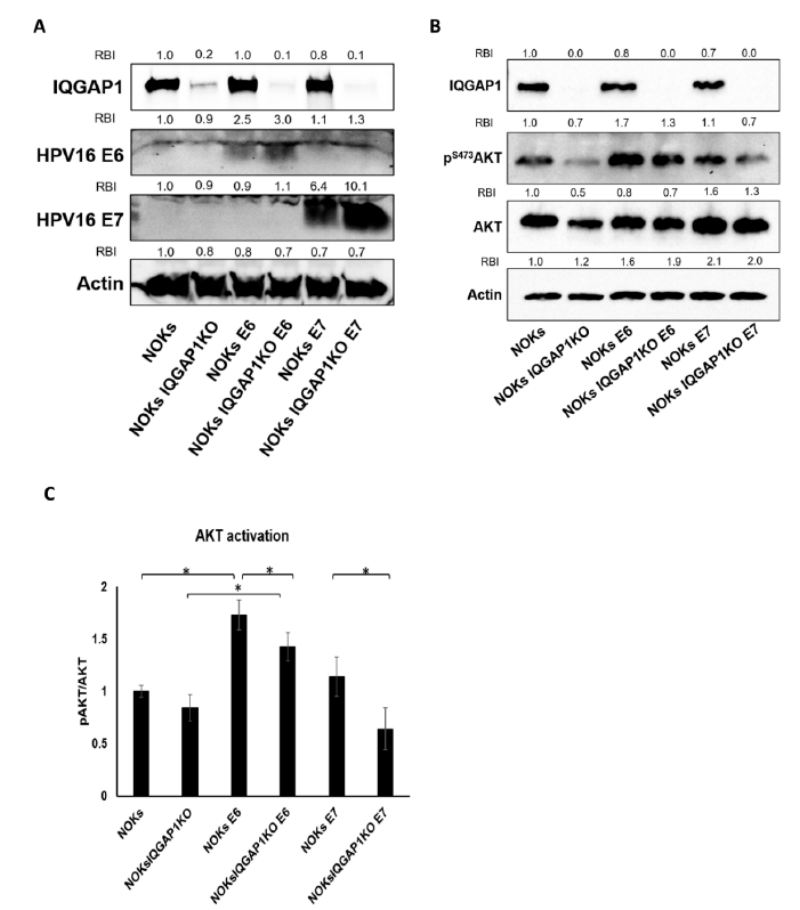
Figure 1. IQGAP1 is necessary for efficient HPV oncoprotein-induced PI3K signaling. ( A ) Im- munoblot to confirm the expression of IQGAP1, HPV16 E6, and HPV16 E7 in the constructed IQGAP1 KO NOKs-HPV cell lines. Relative band intensity (RBI) was calculated by normalizing to the band intensity of NOKs lane. ( B ) Immunoblot shows that stable expression of HPV16 E6 and E7 regulates PI3K signaling in NOKs cell, in part depending on IQGAP1. RBI was calculated by normalizing to NOKs lane. ( C ) Quantification of immunoblot in ( B ). AKT activation was determined by calculating the ratio of p S473 AKT over the levels of total AKT. The intensity of the immunoblots was analyzed by ImageJ, and the graph shows mean ± standard deviation of three independent experiments. Statistics: NOKs vs. NOKs IQGAP1 KO , p = 0.12; NOKs vs. NOKs E6, p = 0.001; NOKs E6 vs. NOKs IQGAP1 KO E6, p = 0.05; NOKs IQGAP1 KO vs. NOKs IQGAP1 KO E6, p = 0.005; NOKs vs. NOKs E7, p = 0.34; NOKs E7 vs. NOKs IQGAP1 KO E7, p = 0.03; NOKs IQGAP1 KO vs. NOKs IQGAP1 KO E7, p = 0.19. All statistical analysis in this figure was conducted with two-sided t -test. Asterisks represent statistical significance. Note: all uncropped western blot images for this study are summarized in Figure